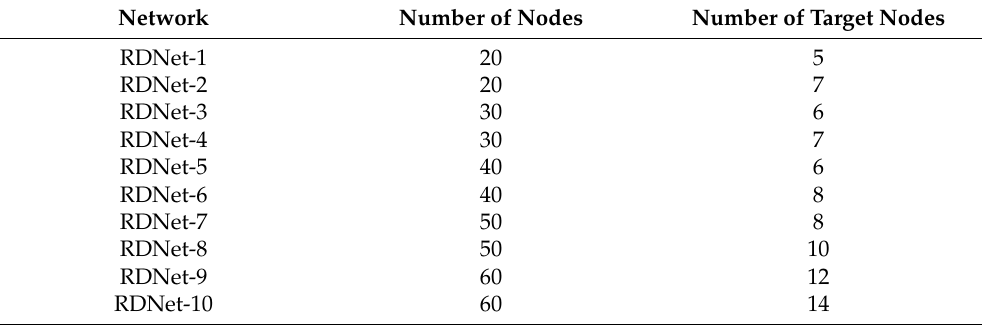
Table 1. Random network topology specifications.